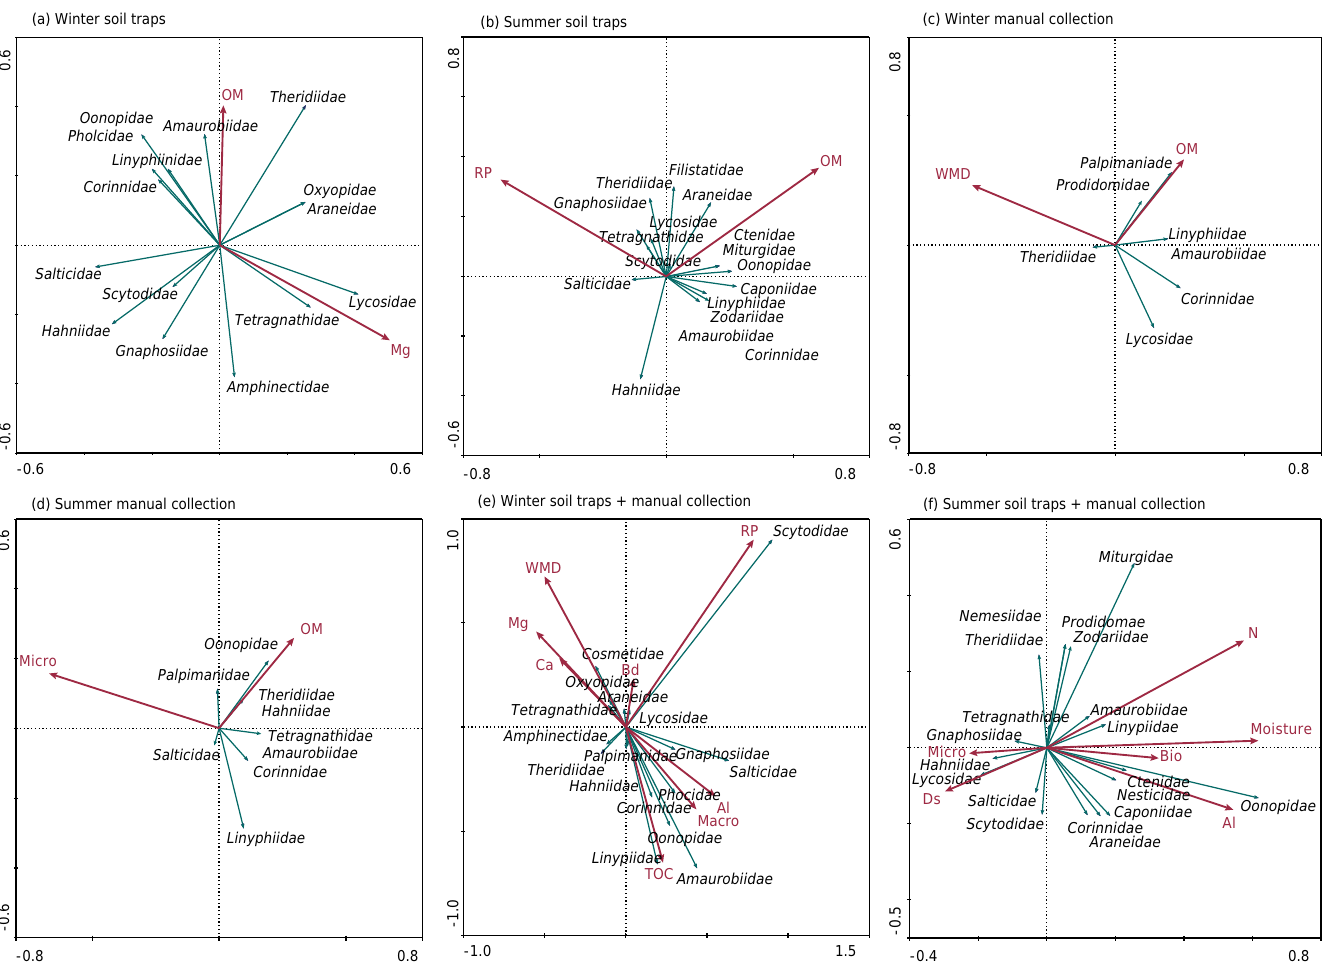
Figure 3. Redundancy analysis (RDA) for spider families (in italics) and environmental variables (in red) in western Santa Catarina in two seasons: winter and summer. Two methods of collection (traps and manual collection); OM = organic matter; Mg = magnesium; RP = resistance to root penetration; WMD = weighted mean diameter; Micro = microporosity; Macro = macroporosity; TOC = total organic carbon; Al = aluminum; Bd = soil bulk density; Ca = calcium; Bio = biopores; N = nitrogen; Moisture = soil